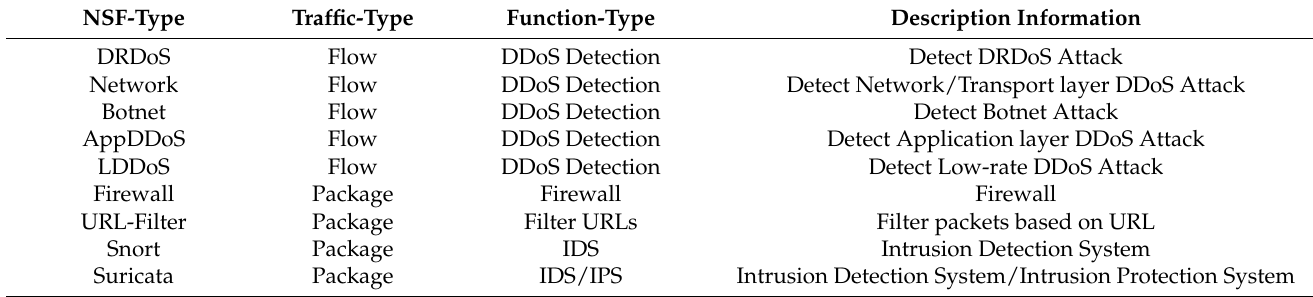
Table 2. Path Policy Data Model.